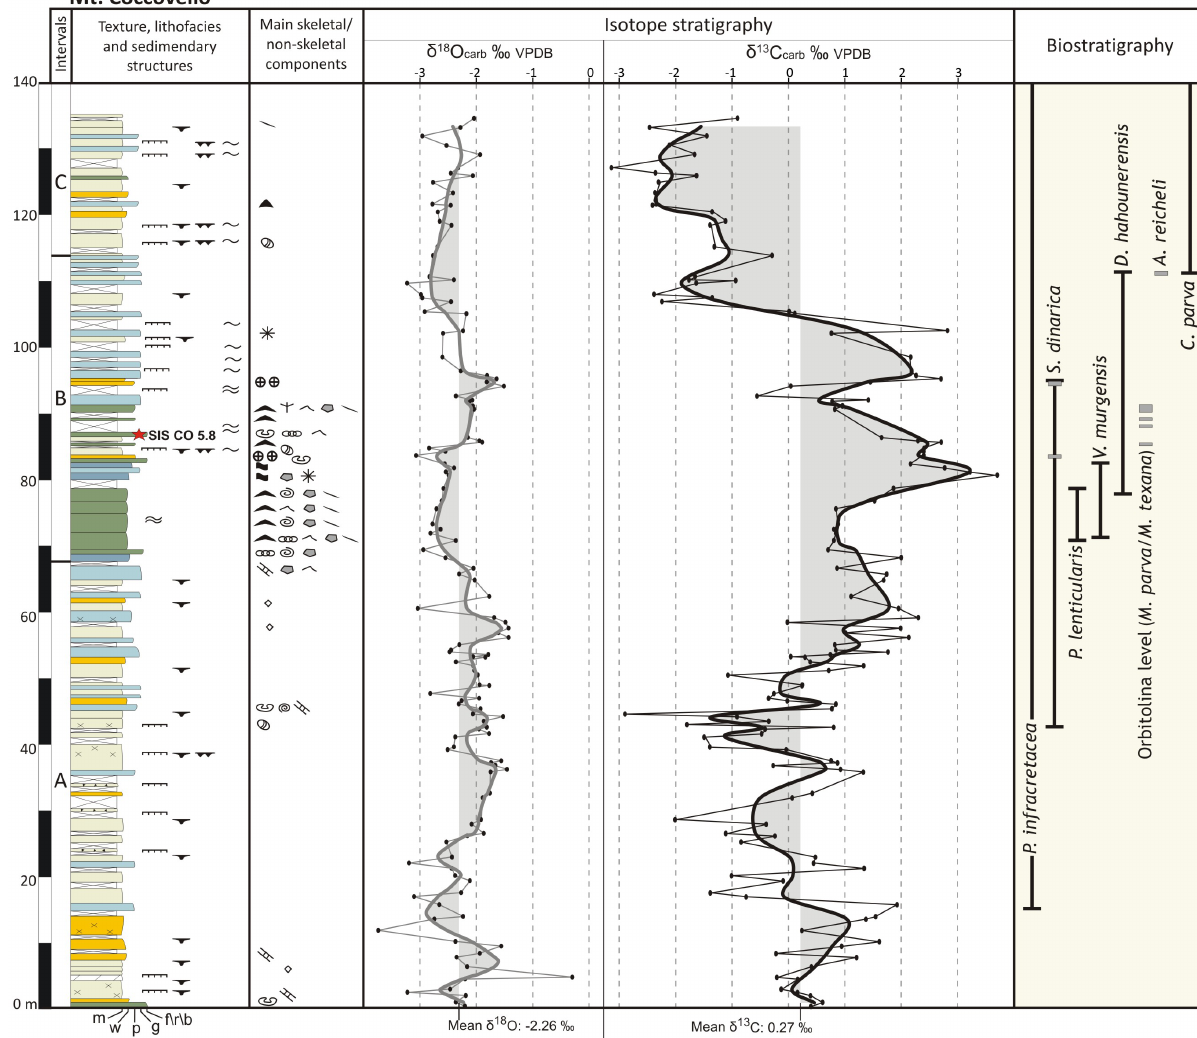
Fig. 12. Mt. Coccovello section: lithological–sedimentological log, isotope stratigraphy and biostratigraphy. The thick curves represent the 3-point moving averages of O- (grey) and C-isotope ratios (black). See Fig. 8 for a key to colours, patterns and